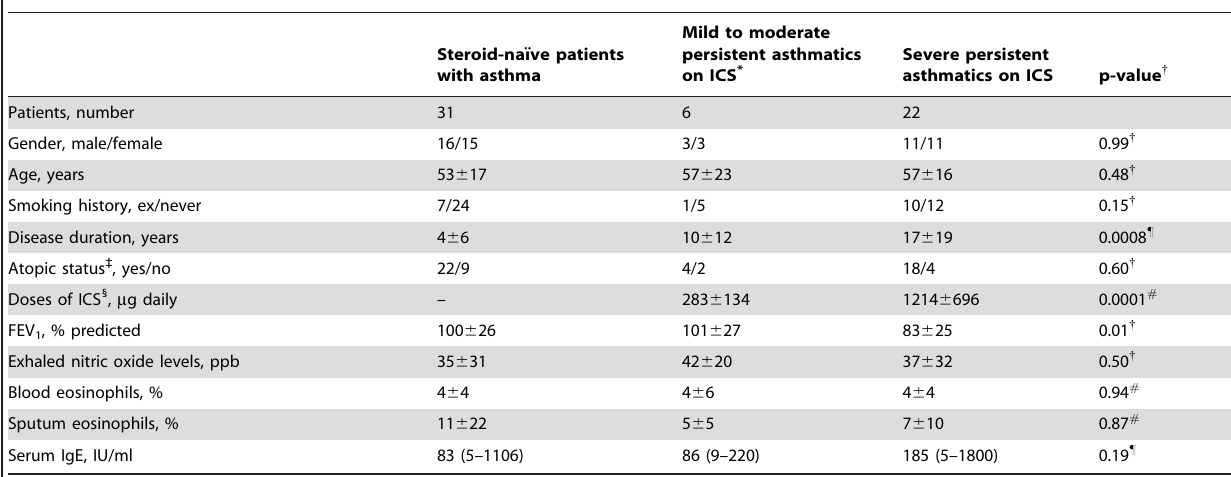
Table 1. Patients’ characteristics.